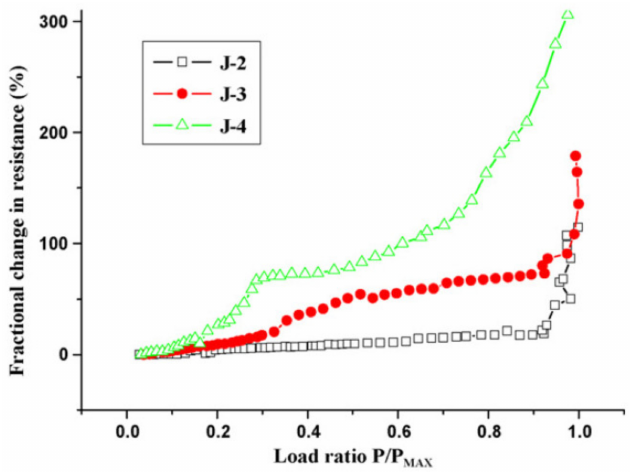
Figure 20. Variation of fractional change in electrical resistance versus load ratio for various CFRC layer thickness: J-2 (30 mm), J-3 (60mm) and J-4 (90 mm). Reproduced with permission from [72], Elsevier,